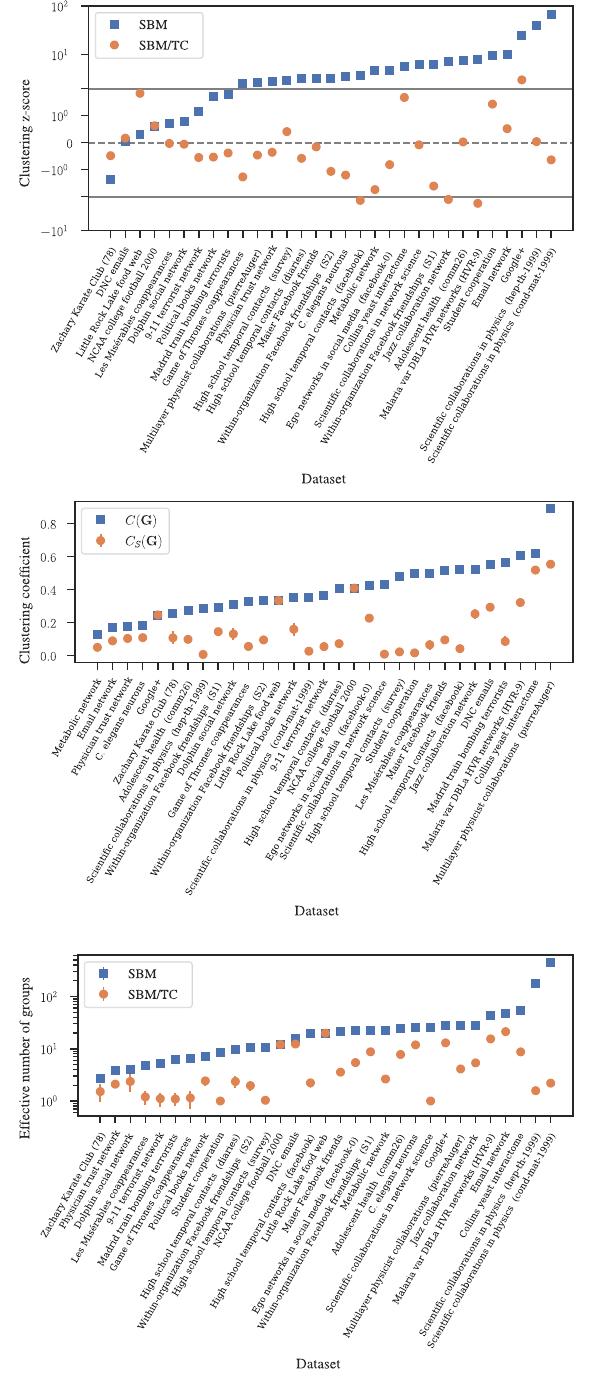
FIG. 9. Top panel: values of the z score for the posterior predictive distributions of the clustering coefficient, as described in the text, for the SBM and SBM/TC, as indicated in the legend, for different data sets. The solid horizontal lines mark the values − 2 and 2. Middle panel: values of the clustering coefficient [Eq. (34)] computed for the original network, C ð G Þ , and for the G Þ , averaged over the posterior inferred seminal network, C S ð distribution according to Eq. (37), as shown in the legend. Bottom panel: values of the effective number of inferred groups, as given by Eq. (33), for the SBM and SBM/TC, as indicated in the